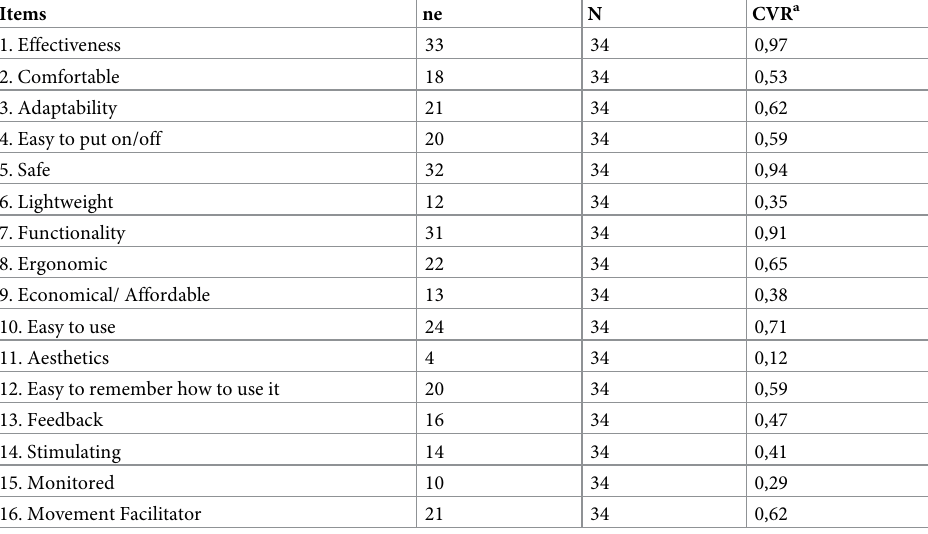
Table 3. Content validity ratio